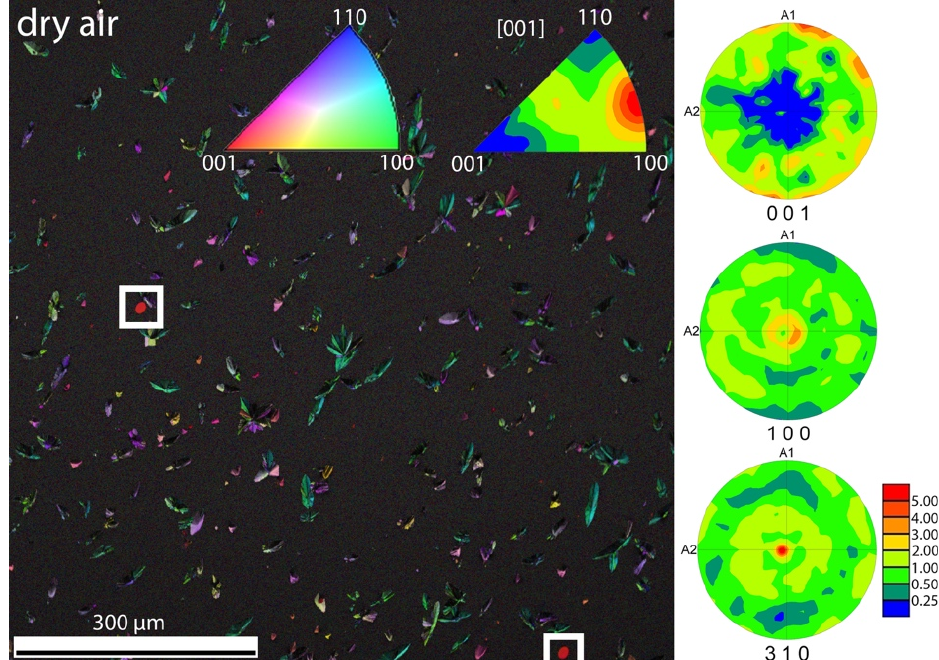
Figure 7. Texture and orientation data for a sample heat-treated in dry air. Left: 001 inverse pole figure mapping and [001] inverse pole figure of the texture (top right). Right circles: pole figures 001, 100 and 310. The boxed red dots are flat circular structures with a radial line pattern.